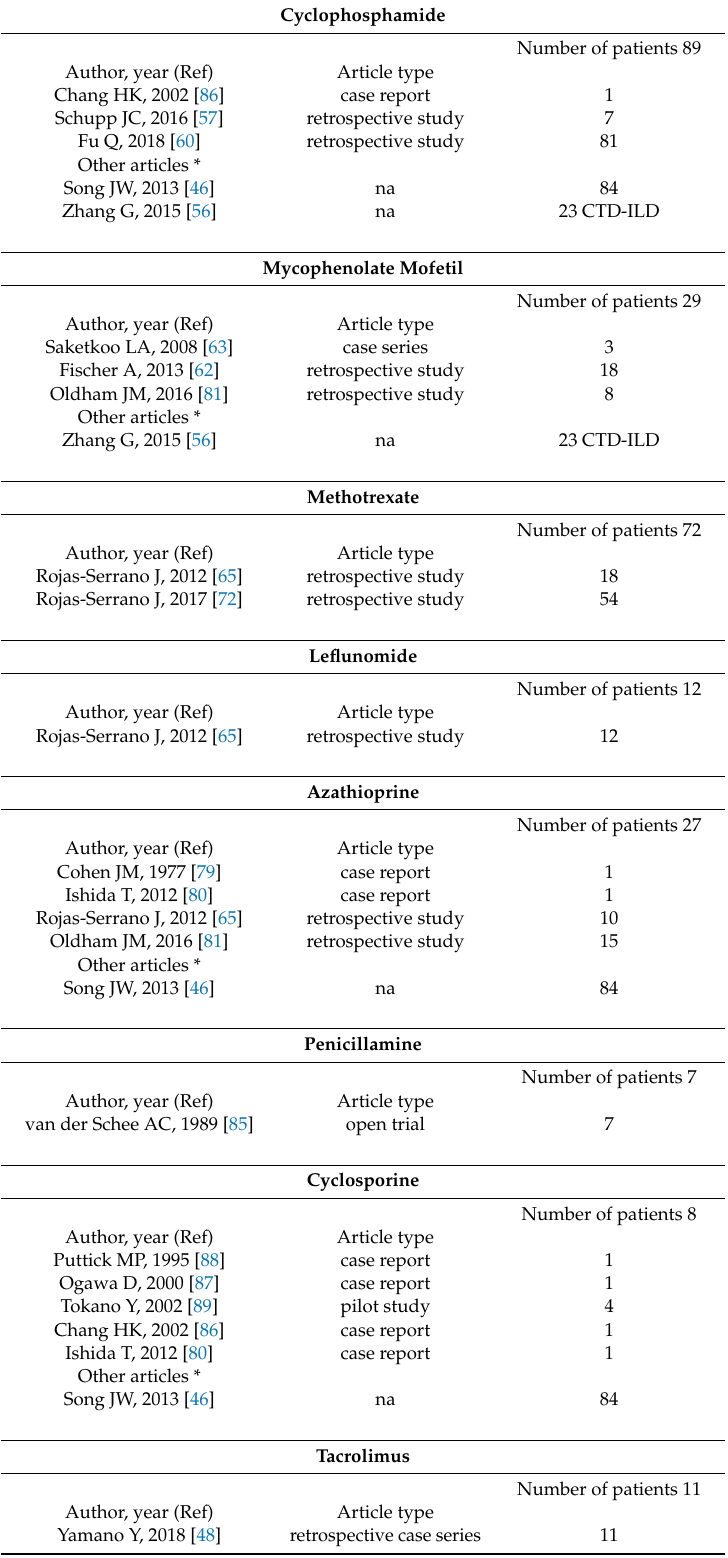
Table 3. Pulmonary e ff ects of immunosuppressants and conventional disease-modifying anti-rheumatic drugs (cDMARDs) in RA-ILD patients: a review of the